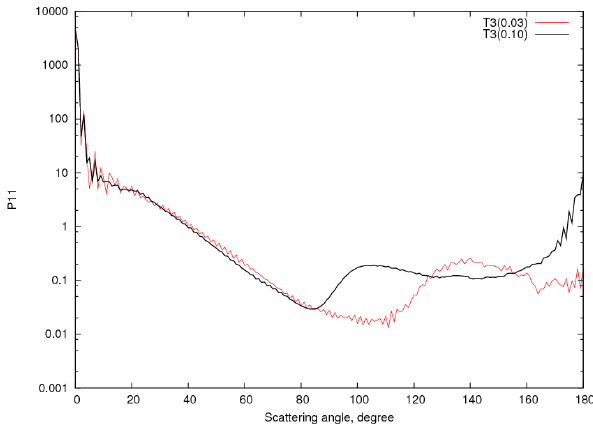
Fig. 4. The normalised scattering phase function plotted against scattering angle, calculated for the Chebyshev particle of order 3 and deformation parameter 0.03, T3(0.03), shown as the red line, and the Chebyshev particle of order 3 and deformation parameter 0.1, T3(0.10), shown as the black line.